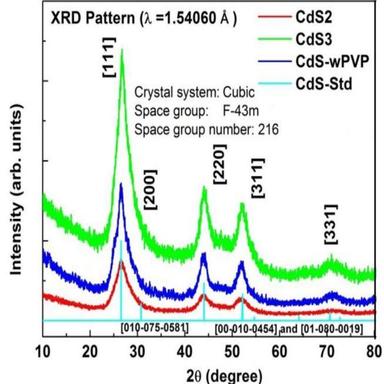
Patterns of XRD for pure 0.1M(CdS3), with PVP 0.1M(CdS-wPVP) and un-doped 0.5M(CdS2).